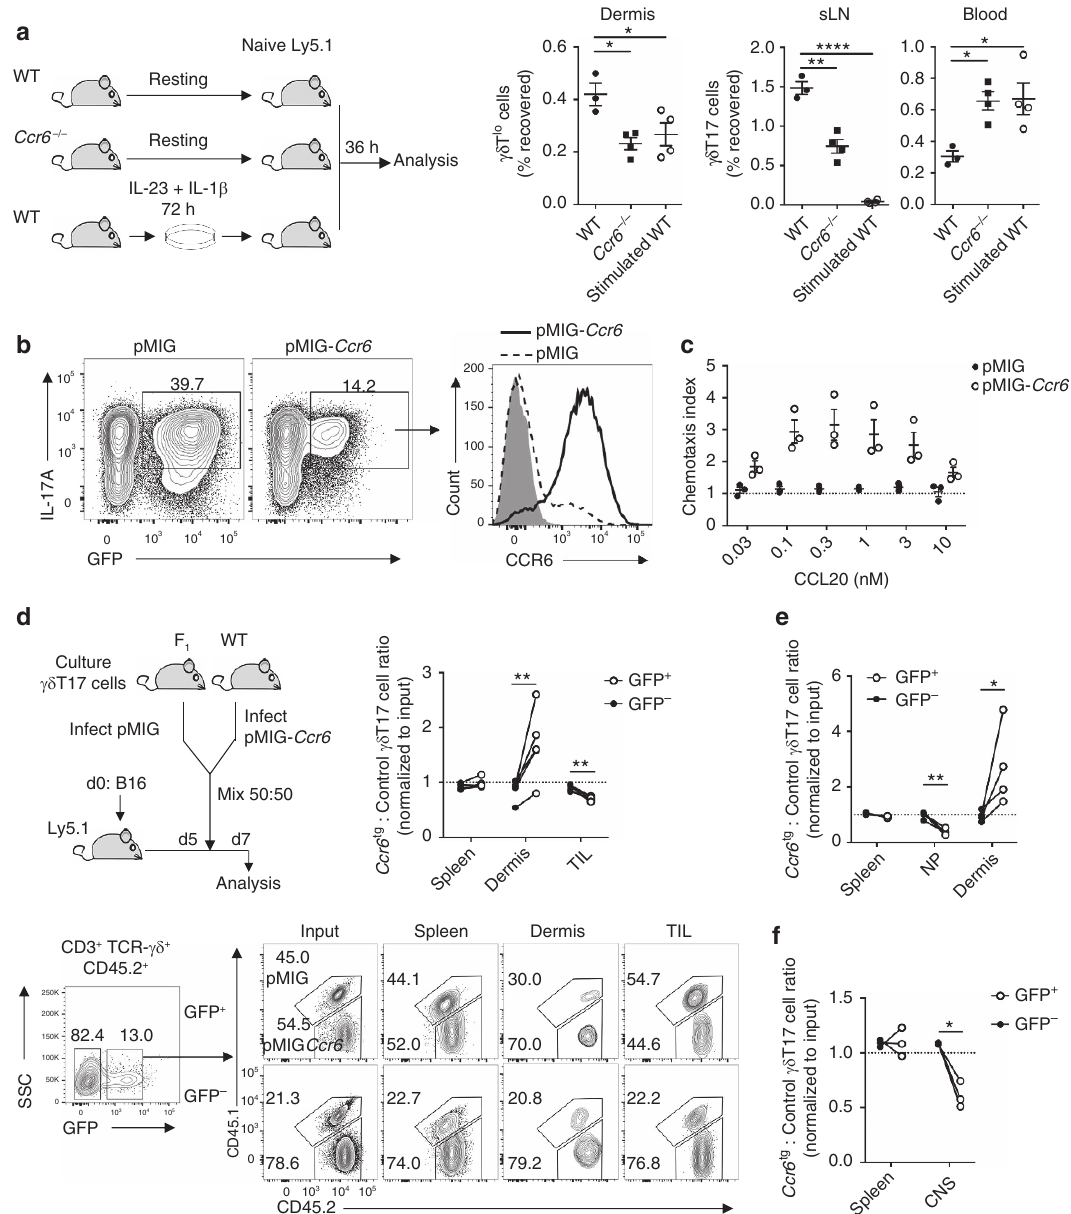
Figure 6 | CCR6 downregulation by cd T17 cells enhances migration to inflamed tissue. ( a ) Resting lymphocytes from wild type (WT) ( n ¼ 3)